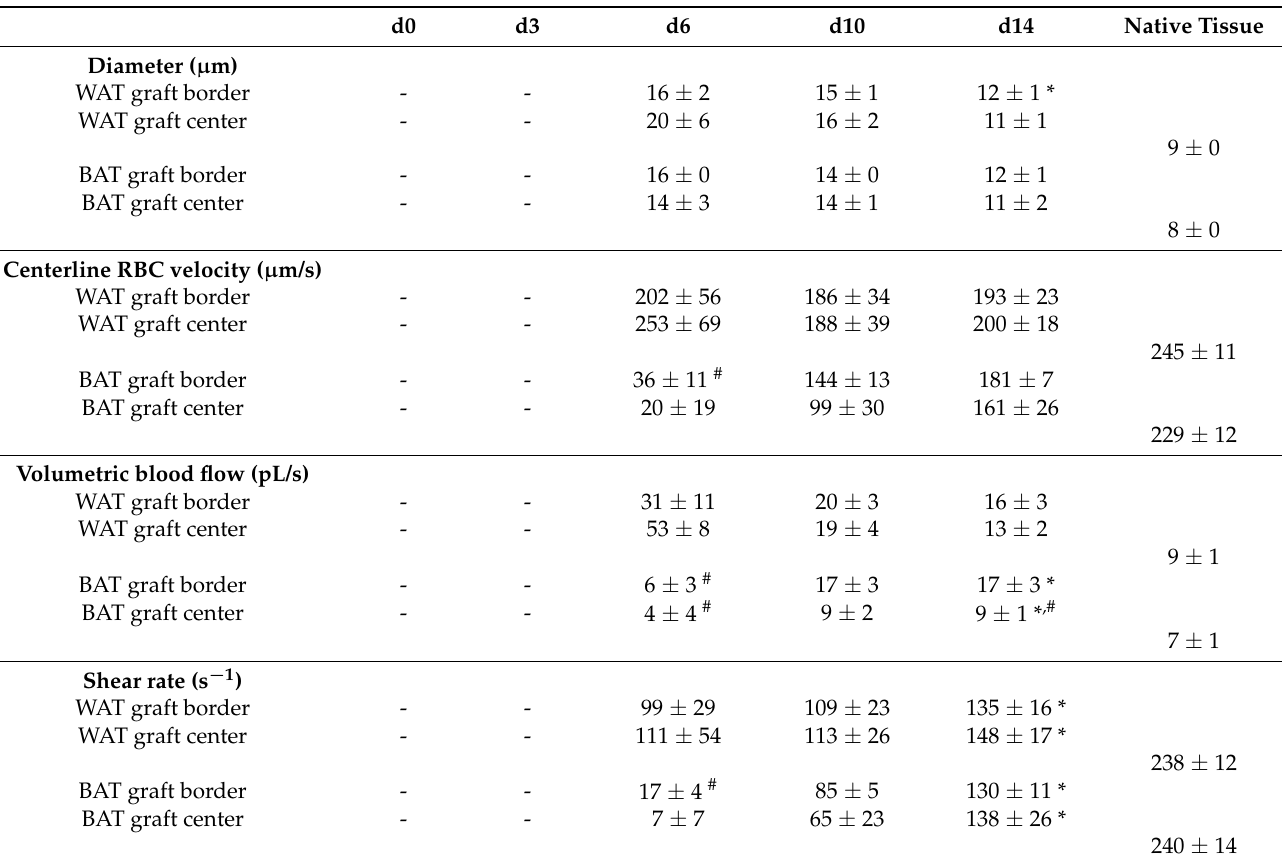
Table 1. Diameter, centerline RBC velocity, volumetric blood flow, and shear rate of microvessels within native WAT and BAT tissue ( n = 5) as well as within the border ( n = 8) and the center ( n = 8) of WAT and BAT grafts on day 0, 3, 6, 10, and 14 after transplantation, as assessed by means of intravital fluorescence microscopy. d0 d3 d6 d10 d14 Native